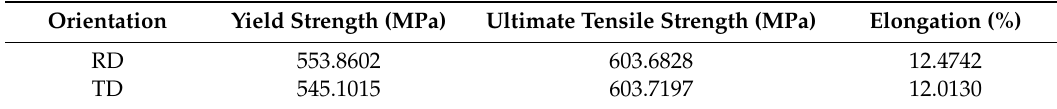
Table 1. Mechanical properties of test sample AA7055-T7751.